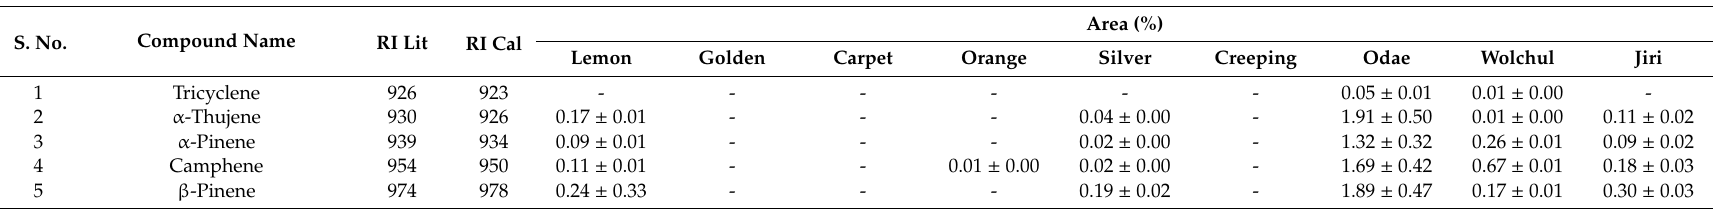
Table4. Thechemicalcompositionofessentialoilsisolatedfromthesixcommercial Thymusvulgaris cultivarsandthethreeKoreannative Thymusquinquecostatus cultivars. S.